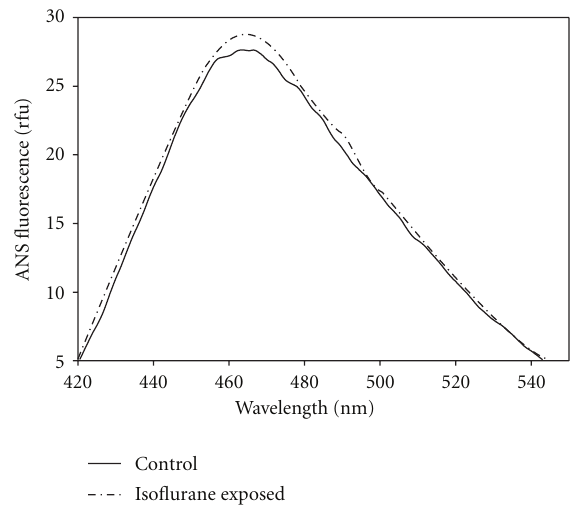
Figure 1: ANS binding to HSA after isoflurane exposure. HSA (75 μ M) was exposed to isoflurane (0.4mM for 1.75 hr at room temperature), dialyzed, and examined for ANS binding versus untreated control. Data are representative